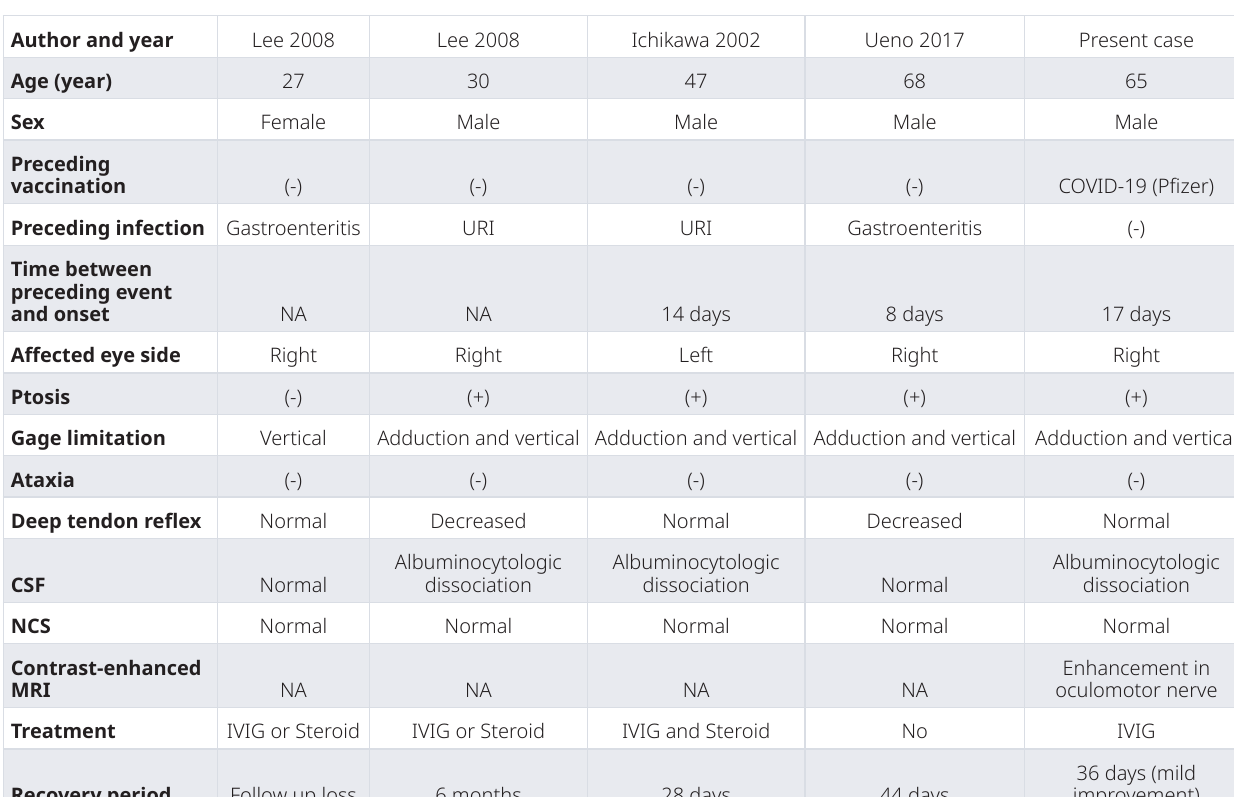
Table 1. Summary of previous reports and present